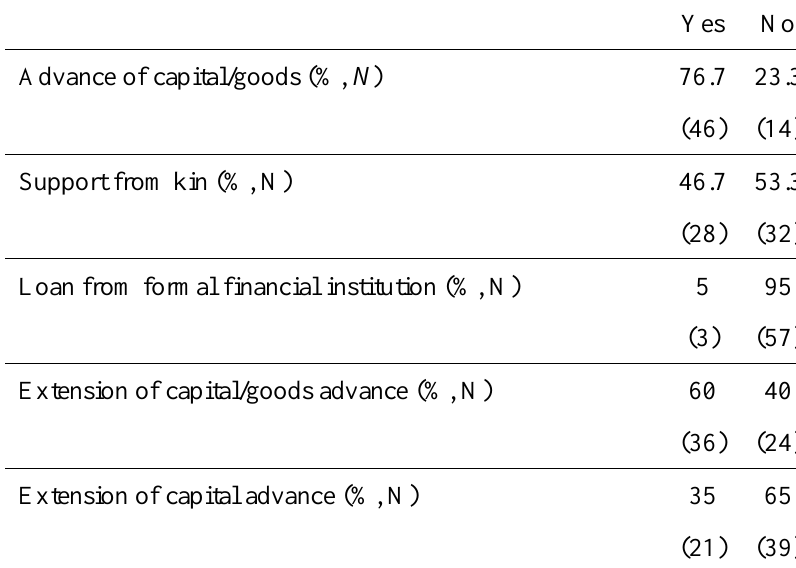
Table 2. Utilization and Provision of Credit